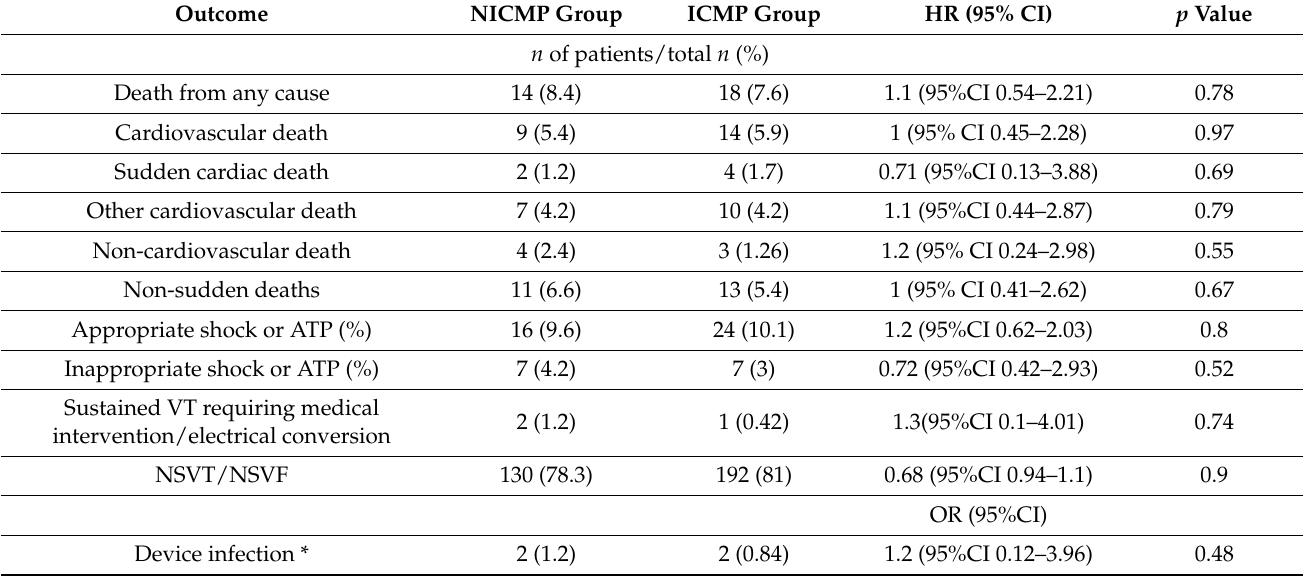
Table 2. Outcomes and adverse